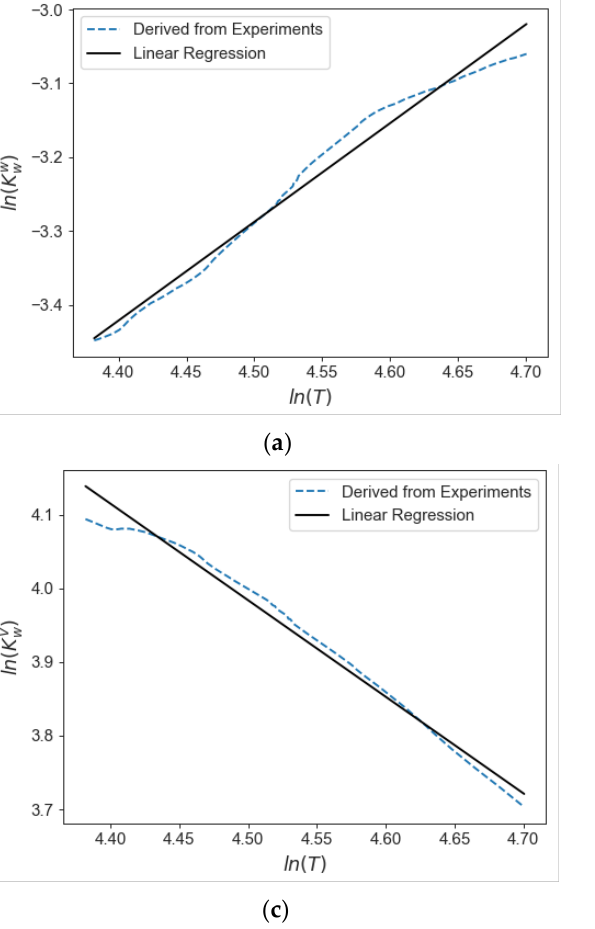
Table 8. Models selected for the prediction of pressure for water/n-octane. Model # Type